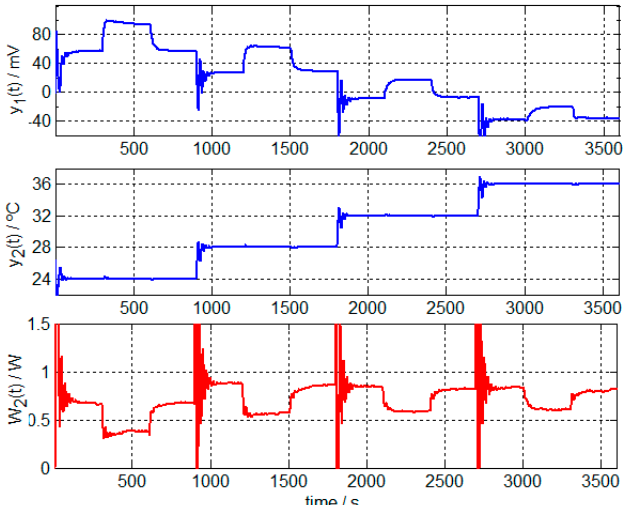
Figure 5. Curves corresponding to four consecutive measurements on the human body (right hand of a healthy 23-year-old male subject) for four different temperatures of the thermostat. These measurements include calorimetric signal y 1 ( t ), thermostat temperature y 2 ( t ) and power dissipated in the thermostat W 2 ( t ).